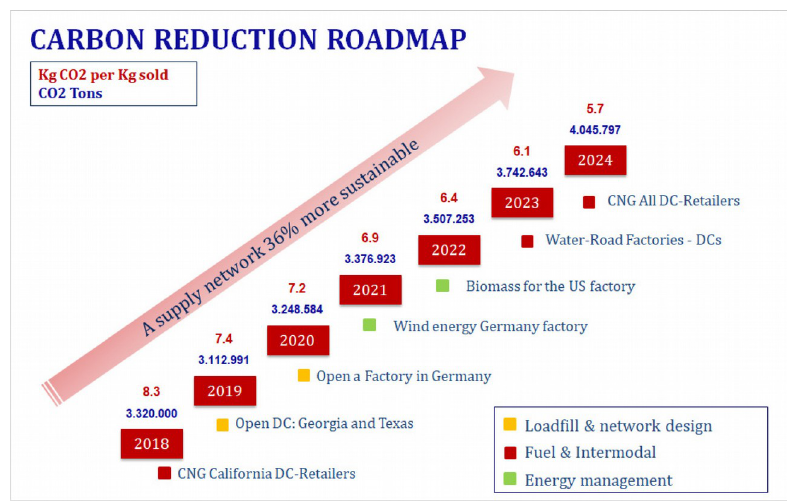
Figure 8. Carbon Reduction Roadmap for the metallurgical